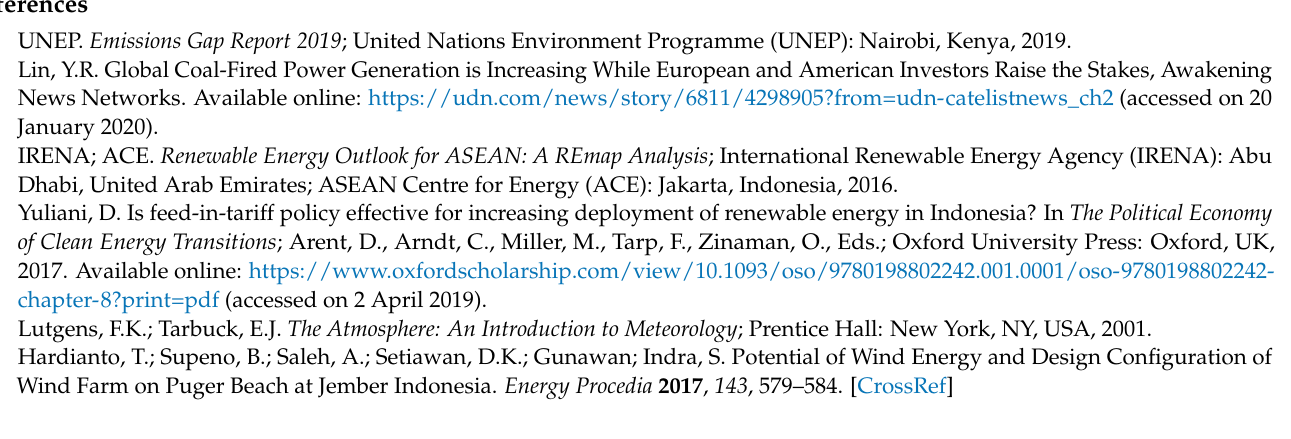
Figure A4. Convergence of the spot values in WindSim. Convergence was achieved after 125 iterations ( top ) to 206 iterations ( bottom ). U1, V1, and W1 are the velocities in the x, y, and z direction, respectively; KE denotes the turbulent kinetic energy; EP refers to the turbulent dissipation rate.